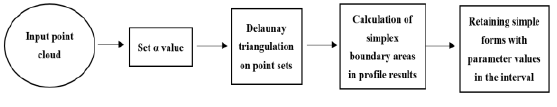
Figure 2 . Comparison of the results of different sampling Table 1 . Comparison of outcome data for different sampling